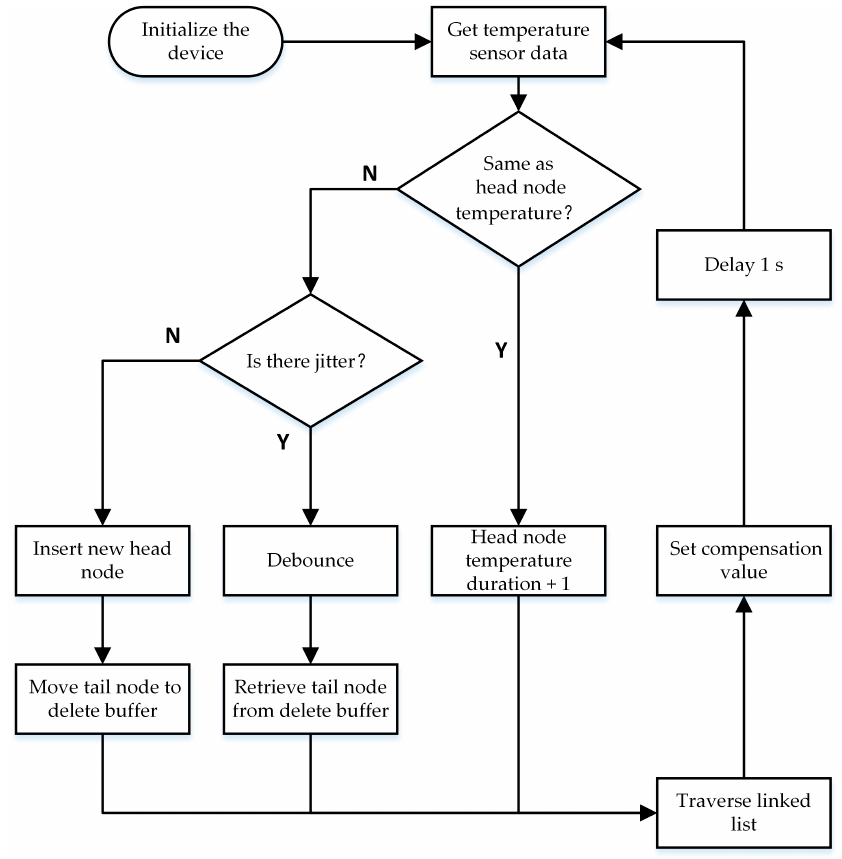
Figure 11. Flow chart of thermal hysteresis compensation.